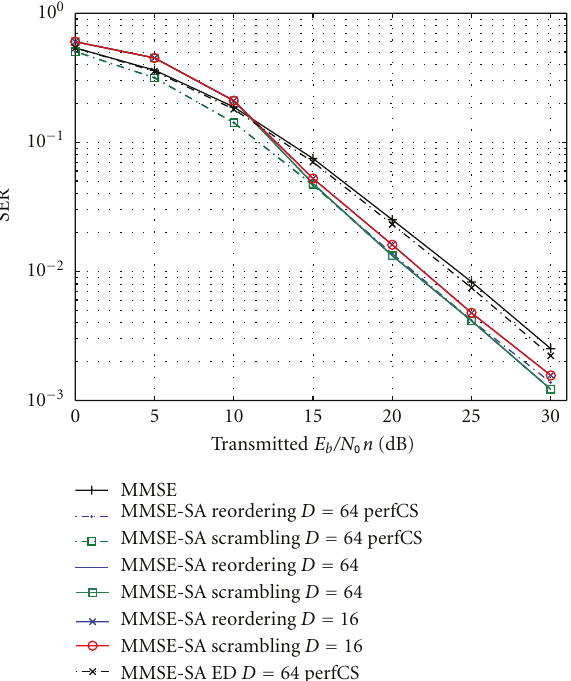
Figure 8: SER versus SNR for MMSE, MMSE-SA with reordering or scrambling, projection-based optimisation and MMSE -SA with Euclidean distance (ED) optimisation N = M = 5, N t = 7,